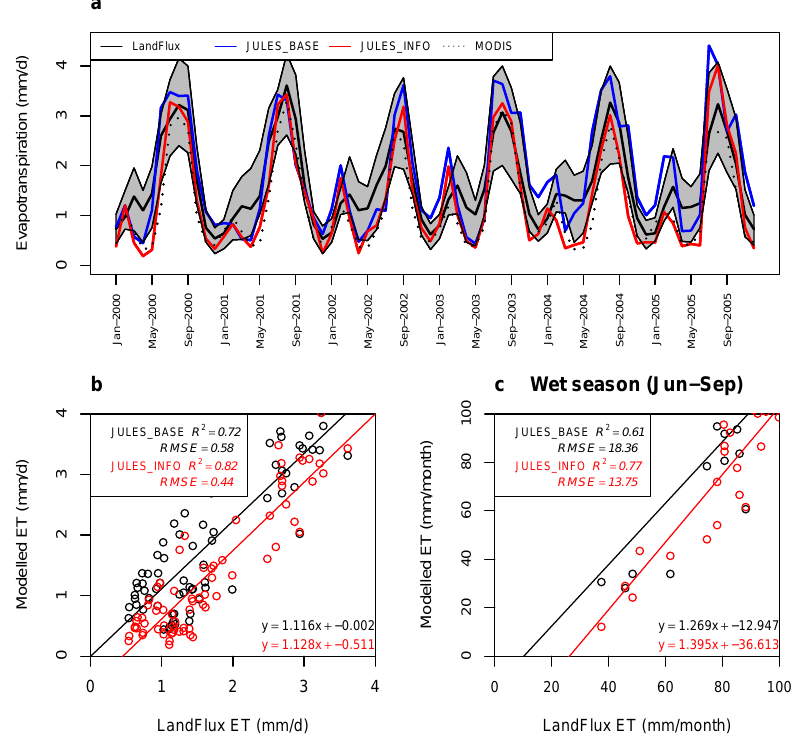
Figure 12. (a) Comparison of the modelled ET with the LandFlux-EVAL product. The shaded area corresponds to the values between the 25th and 75th percentiles of the distribution. (b) Performance scores of the two models (JULES-base and JULES-Info) in comparison with LandFlux-EVAL ET. (c) Results and performance scores only for wet (June–September) period.